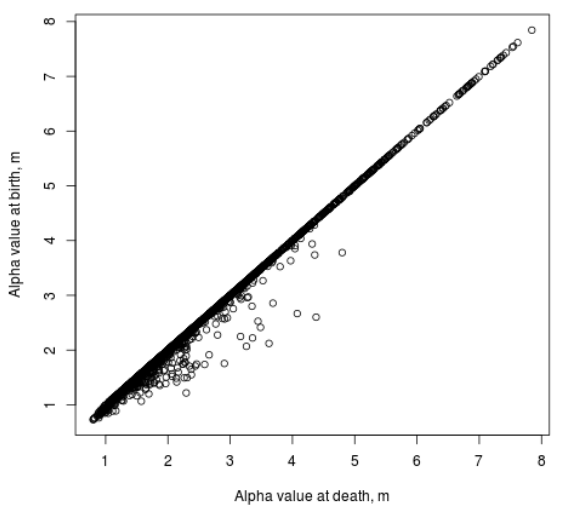
Figure 2. An example birth and death diagram, corresponding to the point data and triangulation of Figure 1. The selected value of α was approximately 5.8 m for this